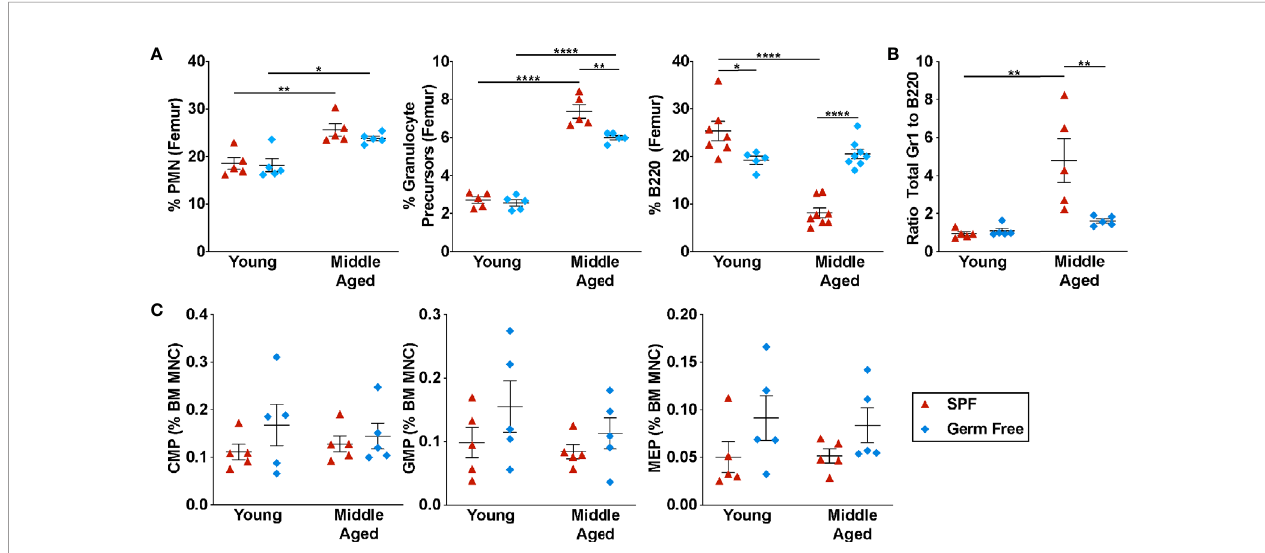
FIGURE 1 | Microbiota signals contribute to the suppression of B lymphopoiesis. (A) Percentage of mature neutrophils (Gr1 hi SSC hi cells, granulocyte precursors (CD115 + Gr1 Int cells), and B220 + cells in the bone marrow. (B) Ratio of Gr1 + cells to B220 + cells in the bone marrow. (C) Percentage of common myeloid progenitors (CMP, lineage – Sca1 – Kit + CD34 + CD16/32 – cells), granulocyte-macrophage progenitors (GMP, lineage – Sca1 – Kit + CD34 + CD16/32 + cells), and megakaryocyte-erythrocyte progenitors (MEP, lineage – Sca1 – Kit + CD34 – CD16/32 – cells) in the bone marrow. Middle aged is de fi ned as 10-12 months. Data represent the mean ± SEM. *P < 0.05, **P < 0.01, and ****P < 0.0001 by one-way ANOVA with alpha = 0.05 and Sidak ’ s multiple comparisons test. Technical replicates were completed at least three times over the span of four years due to availability of germ-free